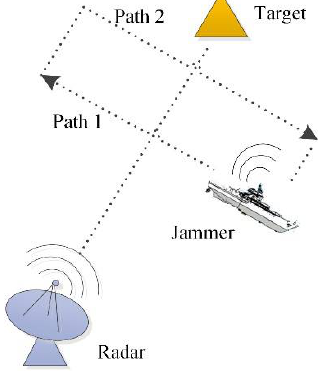
Figure 11. Experimental scenario.